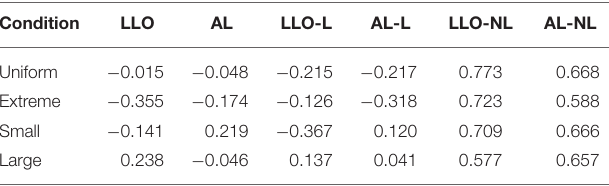
TABLE 2 | Pearson’s r between data and model predictions in the pattern of sequential effects.